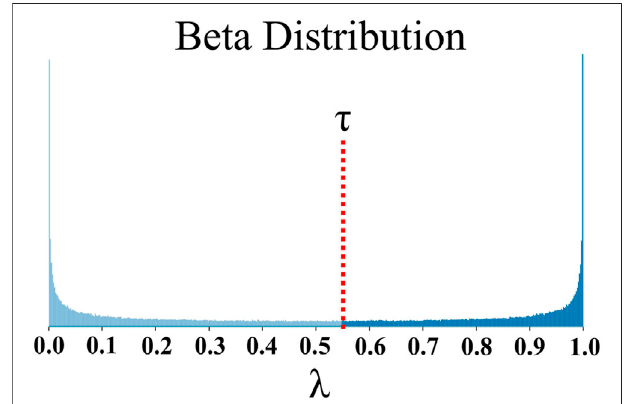
FIGURE 8 | Illustration of a Beta( α , α ) distribution with α (cid:2) 0.4. Using Mixup we generate additional data samples, where the λ selected is always above threshold τ .